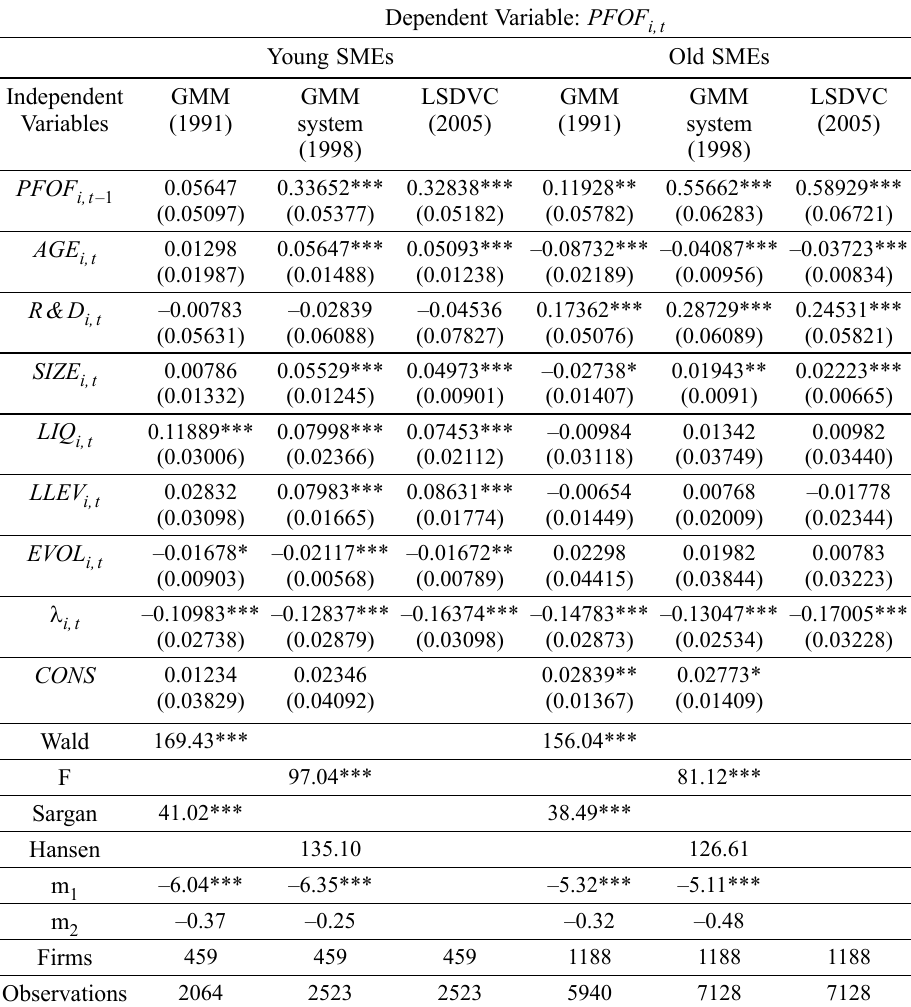
Table 6. Determinants of profitability – Young SMEs and Old